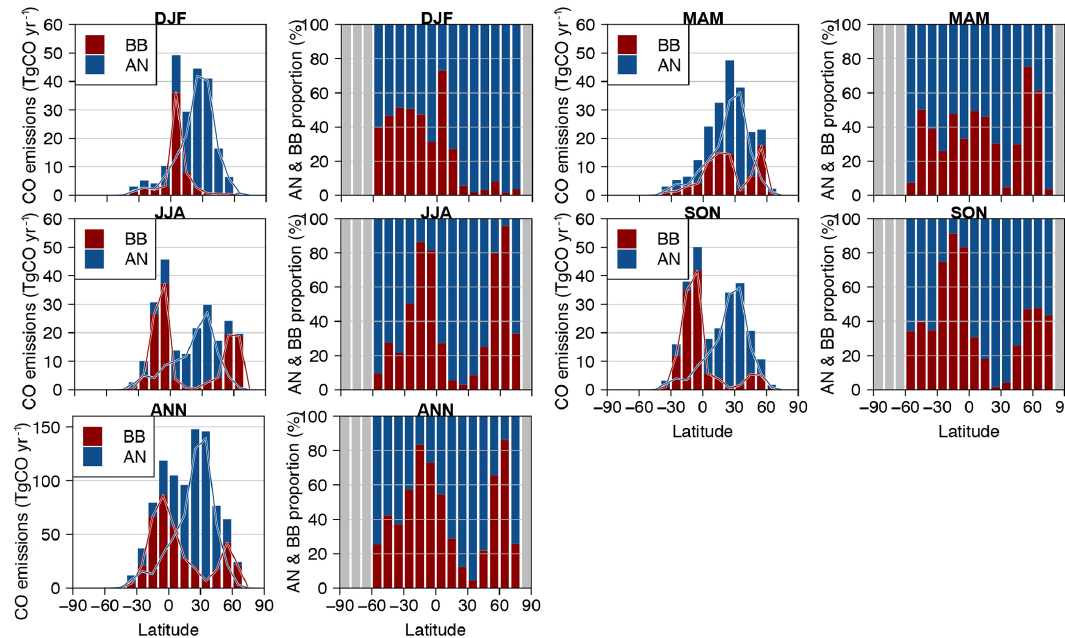
Figure 3. Latitudinal distribution of anthropogenic (AN) and biomass burning (BB) CO emissions. Emissions are given at the annual scale, in absolute (first and third columns) and relative (second and fourth columns) terms. In the plots of absolute emissions, the CO emissions of BB and AN emissions are shown by lines, while the bars indicate the sum of both